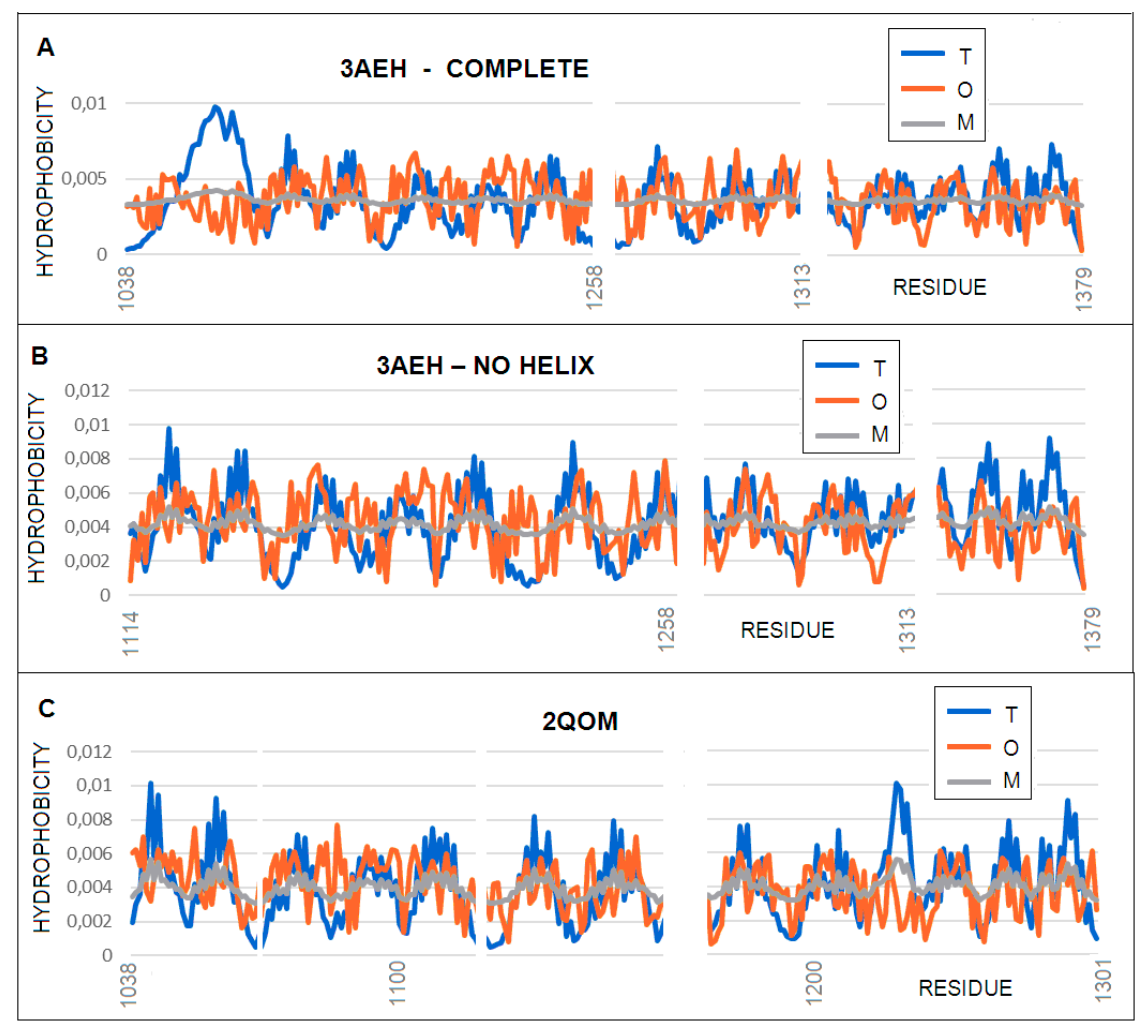
Figure 11. Profiles T (blue), O (red), and M (gray) for: ( A ) 3AEH with a “passenger” present (profile M for K = 1.3), ( B )– 3AEH lacking an N-terminal helix (“passenger”) (profile M for K = 0.7), and ( C )–2QOM without a “passenger” (profile M for K = 0.8).